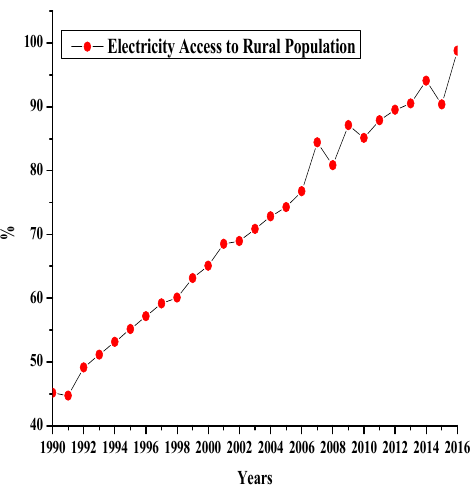
Figure 2. Electricity Access to the Rural Population.